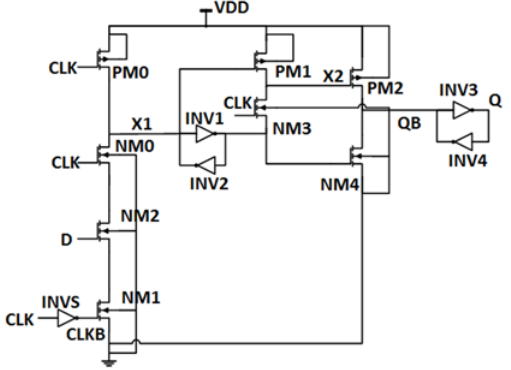
Figure 3. Single ‐ ended conditional capturing energy recovery flip ‐ flop proposed by Mahmoodi et al. [18]. Reproduced with permission from [18], IEEE, 2009.